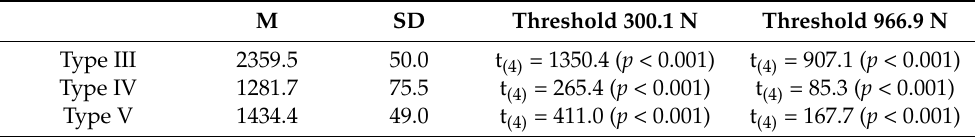
Table 7. Comparison of fracture strength by fracture type.